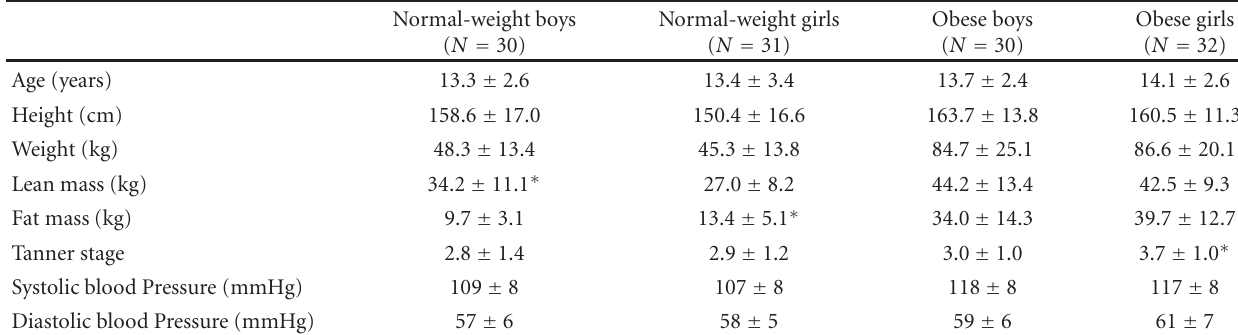
Table 1: Subject characteristics.